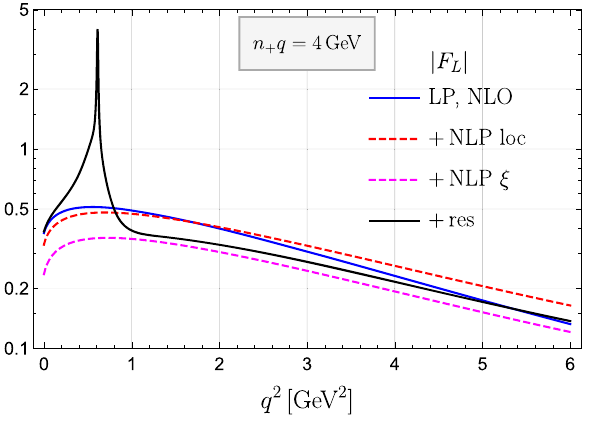
Fig. 4 Illustration of the q 2 dependence of the leading form factor | F | including successively leading power (LP, NLO), next-to-leading L power (NLP) local contributions, ξ and resonances. The value of n + q is fixed to 4